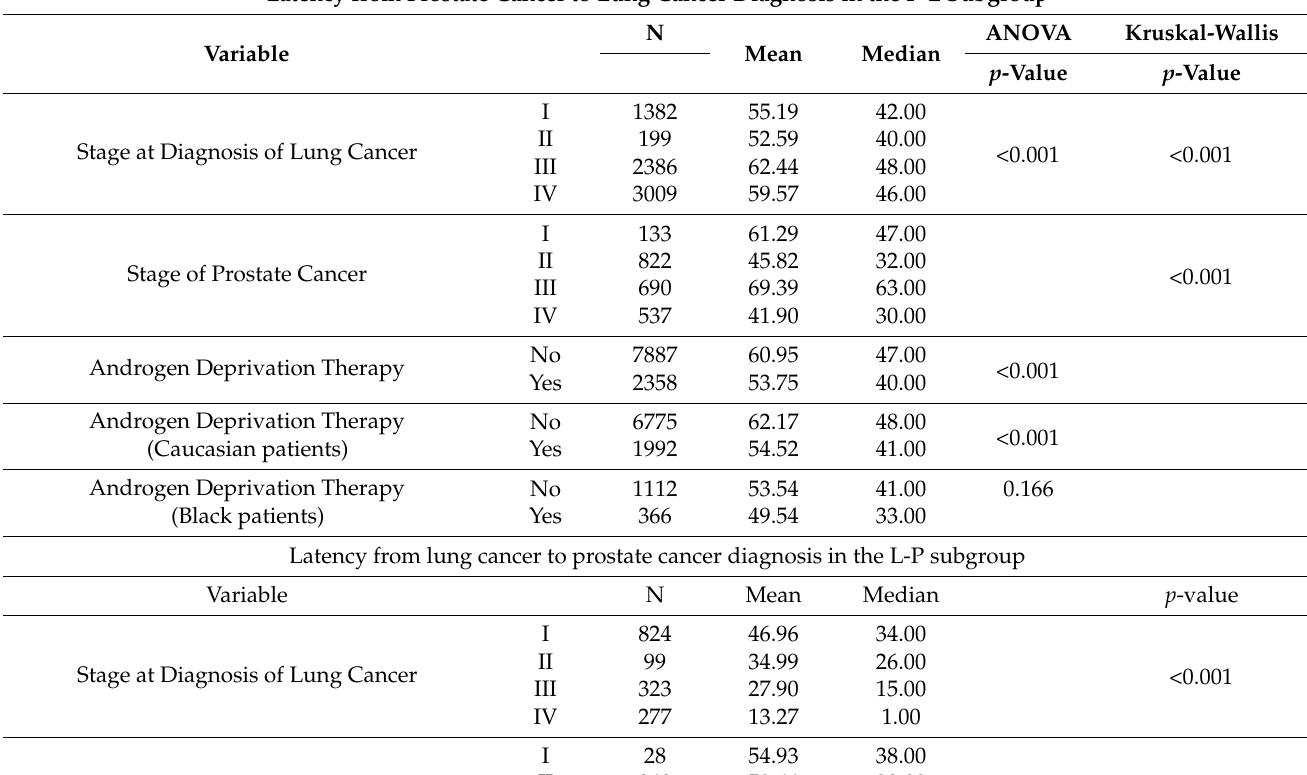
Table 3. Time latency in months between preceding prostate cancer diagnosis and subsequent lung cancer diagnosis according to clinical and tumor